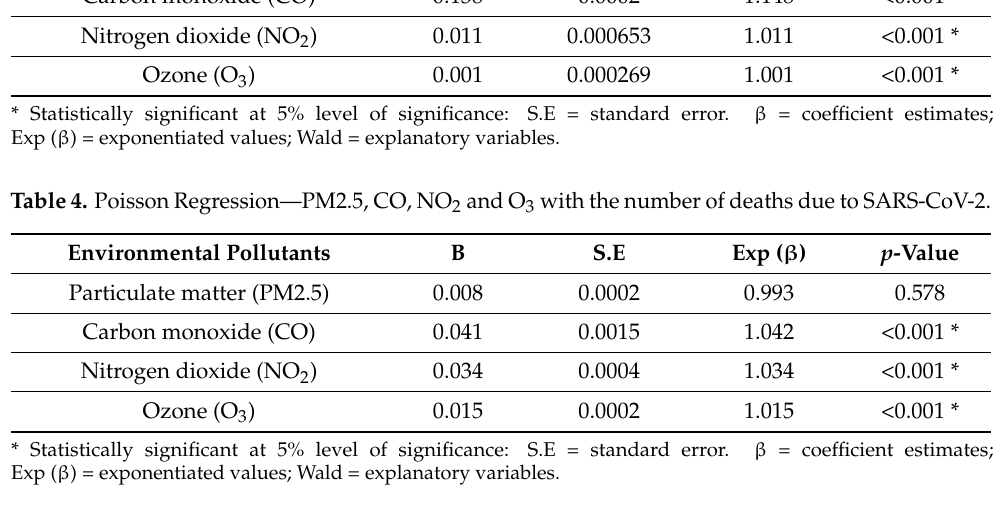
Figure 10. Map: the size of the bubble depicts the volume of SARS-CoV-2 cases and deaths in each region. Recent literature shows that local weather conditions and environmental pollution affect the regional incidence of COVID-19 [7–9,15,16]. It has also been reported that met- ropolitan areas have higher levels of environmental pollution and higher rates of SARS- CoV-2-related new daily cases and deaths. These relationships have been attributed to high particulate matter or Ozone levels [17]. In another study, Coccia (2020) [18,19]